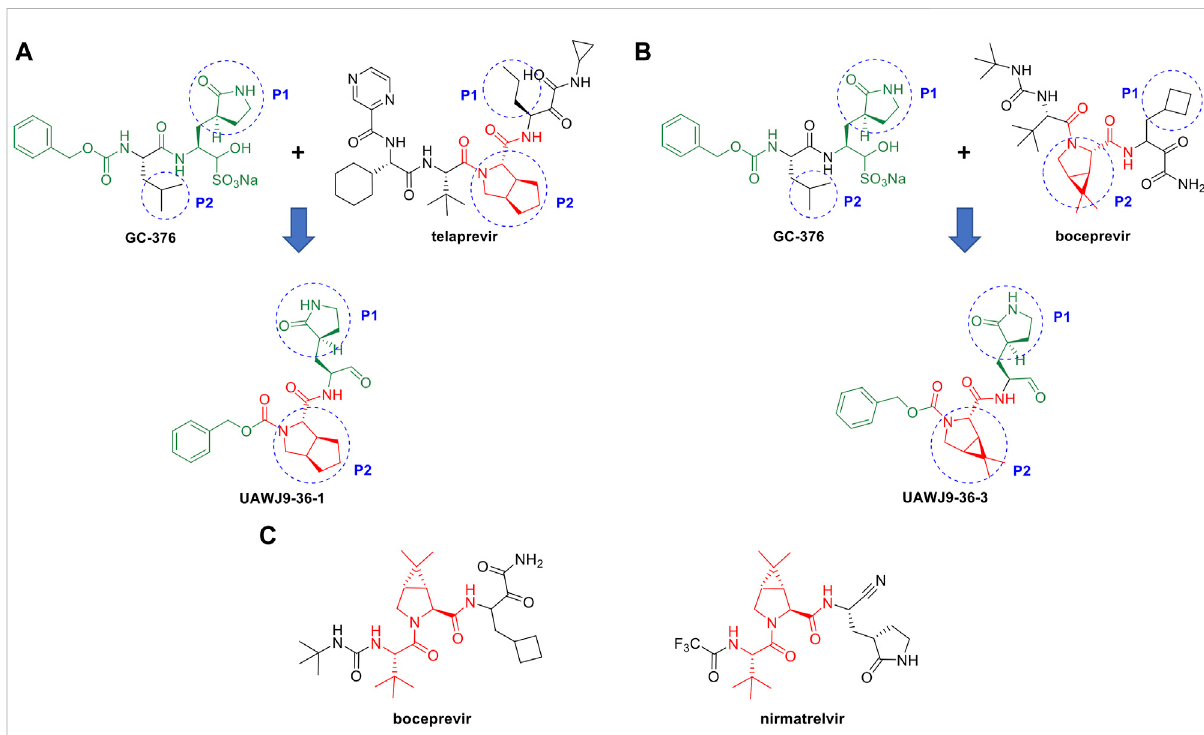
FIGURE 8 Rational design of novel SARS-CoV2 3CL pro inhibitors using HCV NS3/4A protease inhibitor scaffolds. Structure-based drug design of novel SARS-CoV-2 3CL pro inhibitors derived from GC-376 and the HCV protease NS3/4A inhibitors TEL (A) and BOC (B) . The structure of P fi zer ’ s